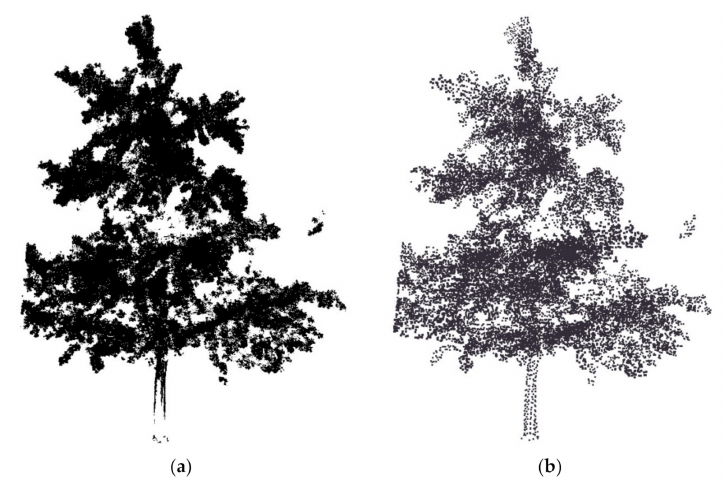
Figure 6. Candidate seeds before and after hybrid voxel filter. ( a ) Candidate point cloud before hybrid voxel filter; ( b ) seeds extracting with hybrid voxel